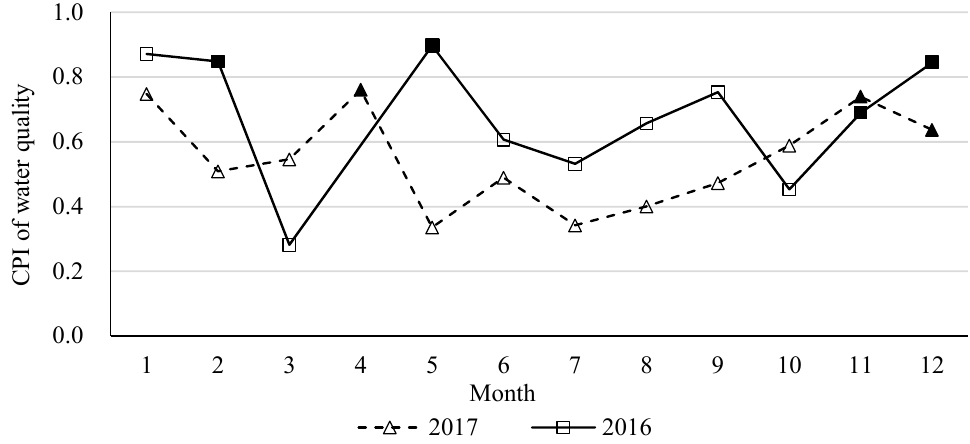
Figure 5. Monthly comprehensive pollution index (CPI) of the Nanhai section of the Southeast Inner River in 2016–2017. The filled triangle or square means the water quality does not satisfy the requirements in this month. CPI is calculated as the average ratios of the monitored and required concentrations of the five indicators (i.e., COD, BOD, ammonia N, TP, and permanganate indexes). Lower values mean better water quality, but the value of CPI does not strictly correspond to whether it satisfies the water quality requirements. (Source: Official website of Foshan Environmental Protection